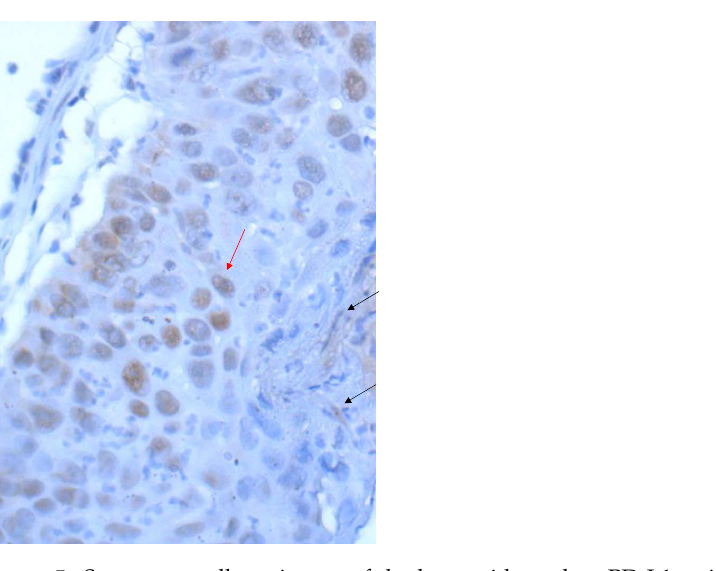
Figure 5. Squamous cell carcinoma of the lung with nuclear PD-L1 staining (red arrow), which is excluded from scoring as well as a weakly positive staining in stroma elements (black arrows) (40 ×